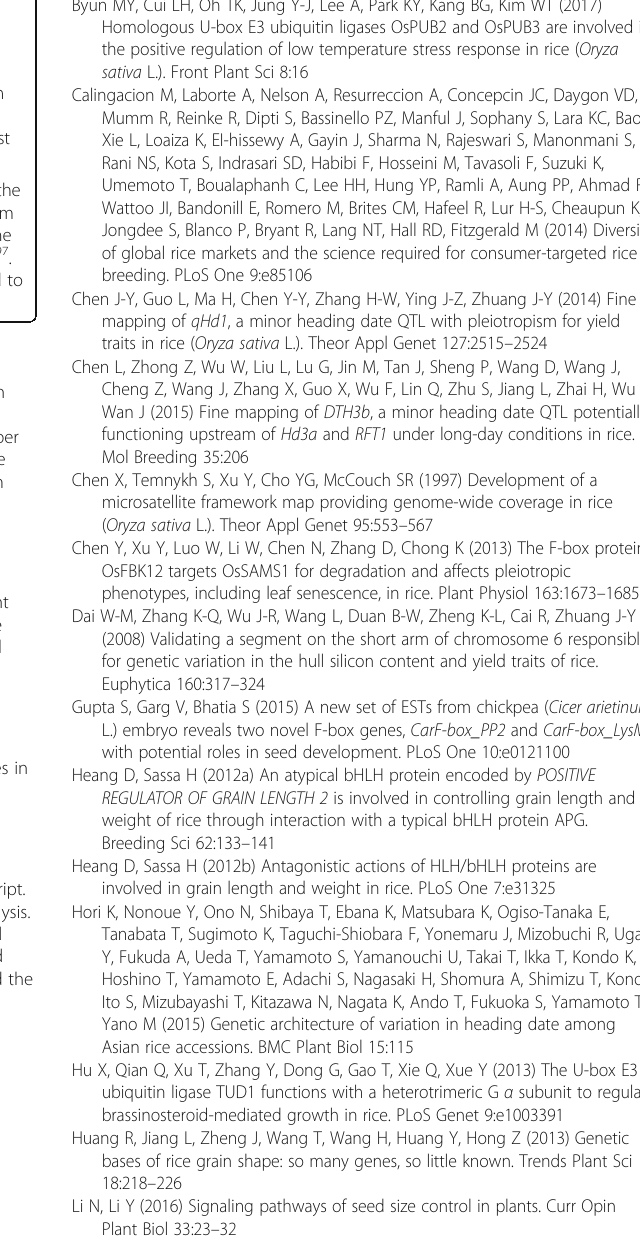
Table S3. Primers used for quantitative real-time PCR. Table S4. Nucleotide and amino acid differences between Zhenshan 97 and Milyang 46. (DOCX 23 kb) Additional file 2: Figure S1. Grains of NIL ZS97 and NIL MY46 for qGS1-35.2. Scale bar, 20 mm. (PDF 1936 kb) Additional file 3: Figure S2. Grains of NIL ZS97 and NIL MY46 for qGW1-35.5. Scale bar, 20 mm. (PDF 1946 kb) Additional file 4: Figure S3. Characterization of the cells in outer glumes of NIL ZS97 and NIL MY46 for qGS1-35.2 . a Scanning electron microscopic images of the cells. Scale bar, 200 μ m. b Cell length, width and number. The cell numbers were measured in the longitudinal direction. Data are presented in mean ± s.e.m. ( n = 20). A Student ’ s t -test was used to generate the P values. (PDF 1633 kb) Additional file 5: Figure S4. Transcript levels of annotated genes in the qGS1-35.2 region. The experiment was performed using panicles of 1 cm (P1) and 8 cm (P8) collected from NIL ZS97 and NIL MY46 for qGS1-35.2 . The expression levels were normalized to Actin1 and related to P1 of NIL ZS97 . Data are presented in mean ± s.e.m. ( n = 3). A Student ’ s t -test was used to generate the P values. (PDF 2579